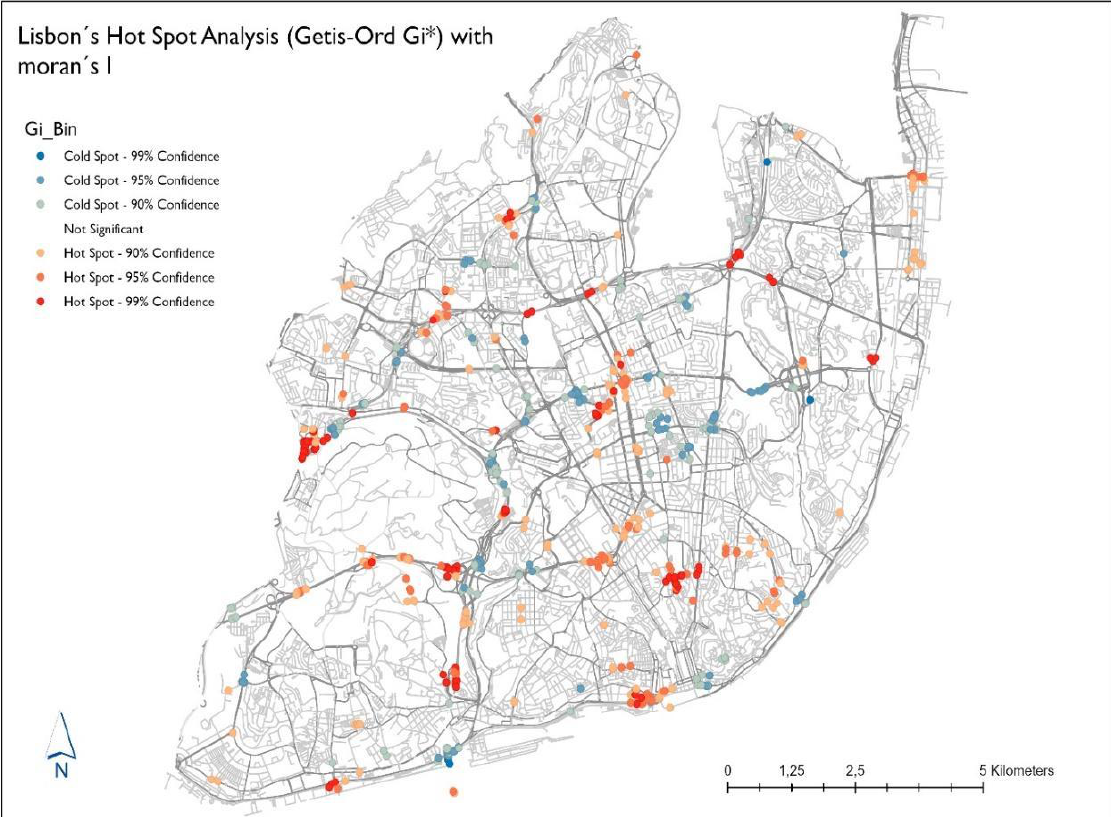
Figure 6. Hotspot analysis (Getis-Ord Gi*) decade analysis 2010 – 2019. Hotspot identification and characterization is depicted in Figure 7. After the identification of the location of statistically significant hotspots performed by the Hotspot Analysis Getis-Ord Gi* algorithm, the results were analyzed, and a selection of the most active hotspots was arranged by the number of accidents and severity of victims was made. If Lisbon Municipality had already applied the Municipal Road Safety Index (ISRM) we could compare this classification with the one calculated by CML.